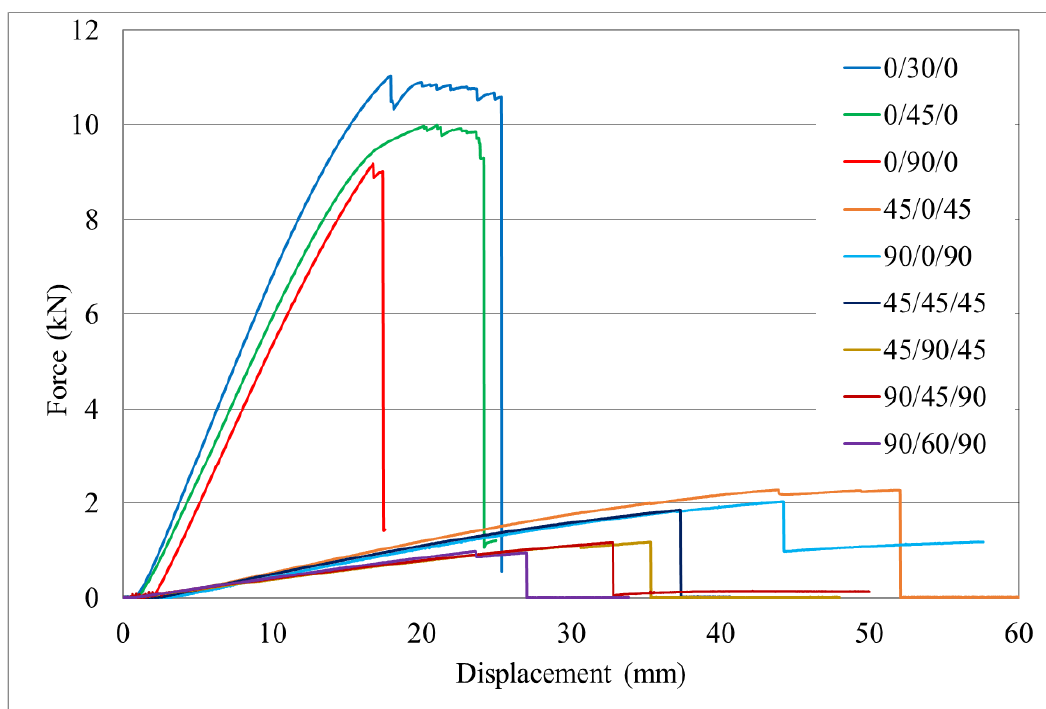
Figure 2. Force – displacement response in each group for bending test samples. Figure 2. Force–displacement response in each group for bending test